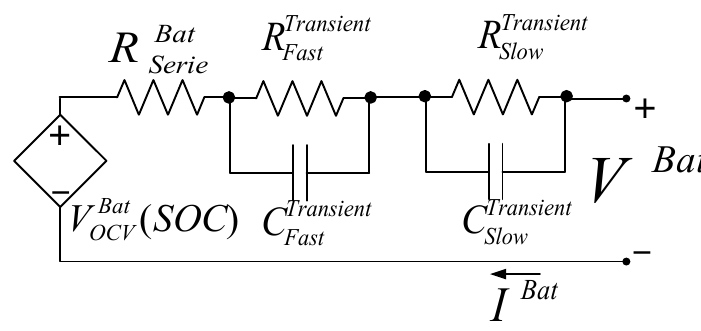
Figure 3. Second order model of the battery bank.